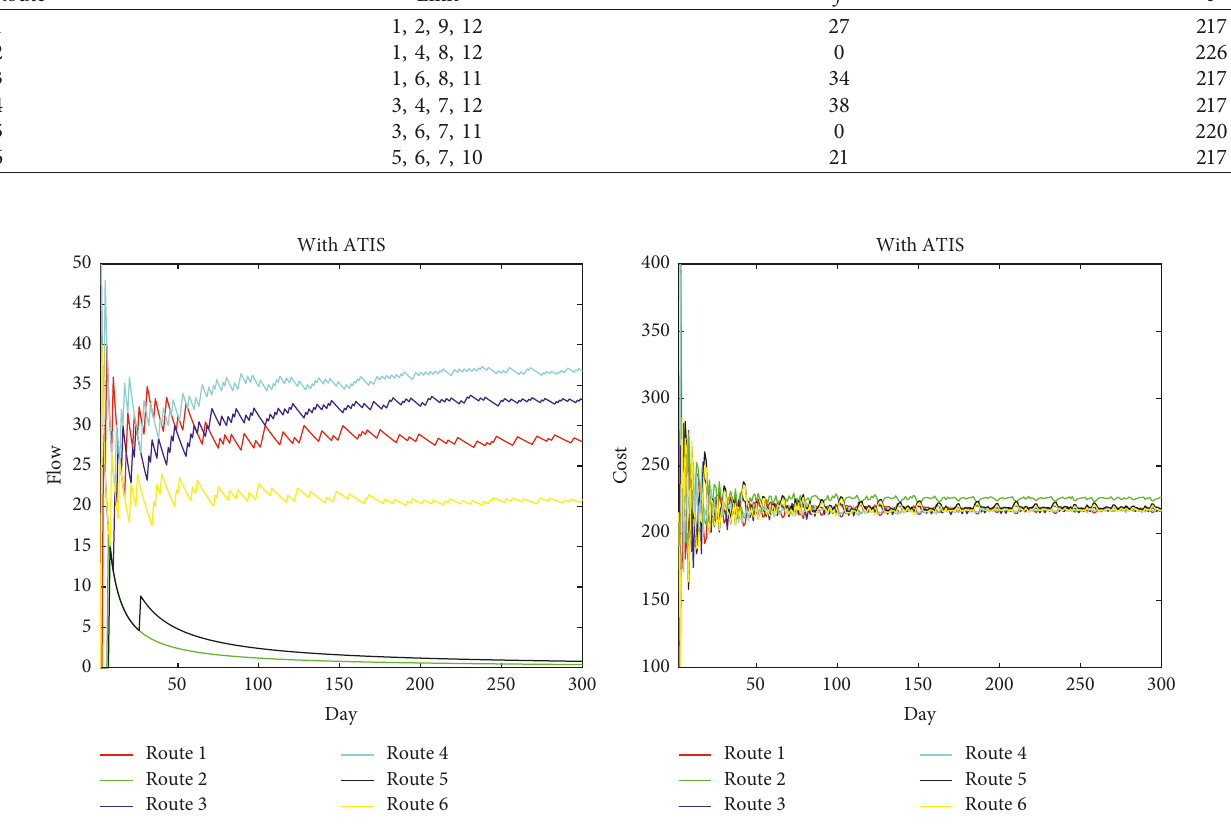
Figure 5: Evolutionary trajectories of route flows (a) and route travel costs (b) for travellers in the first group. Table 6: Route flow and surplus capacity in mixed equilibrium for travellers in the second group.